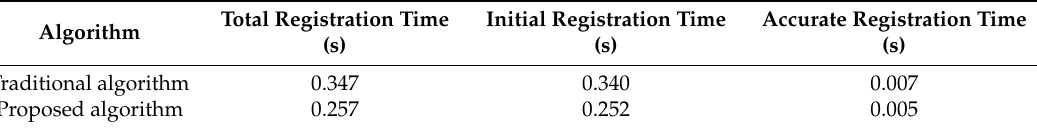
Table 3. Registration time of different